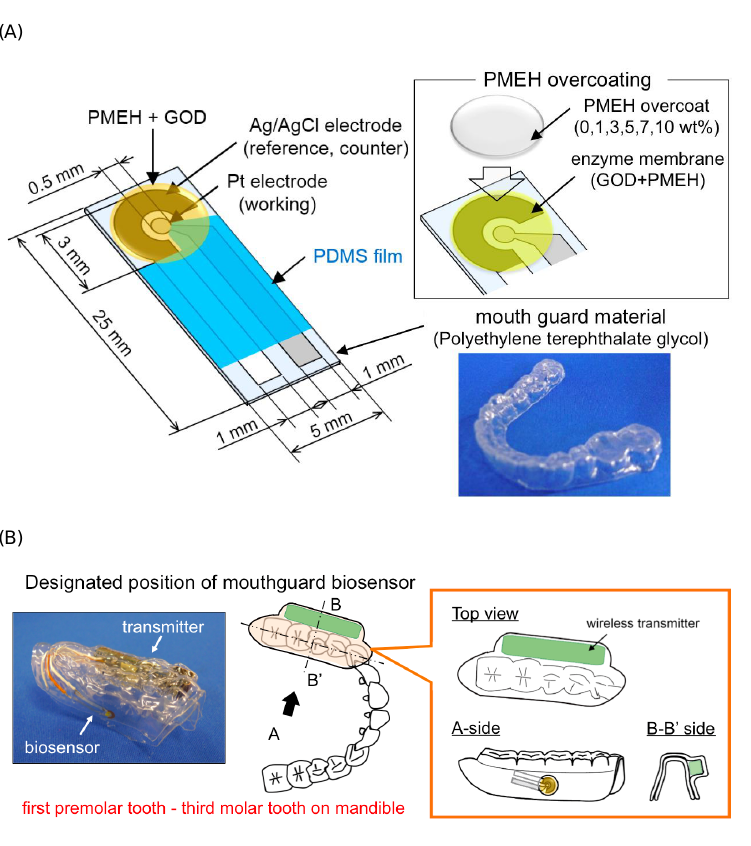
Figure 6. ( A ) Glucose biosensor on the polyethylene terephthalate glycol mouthguard support. 363 ( B ) Mouthguard biosensor to custom-fit the patient’s dentition